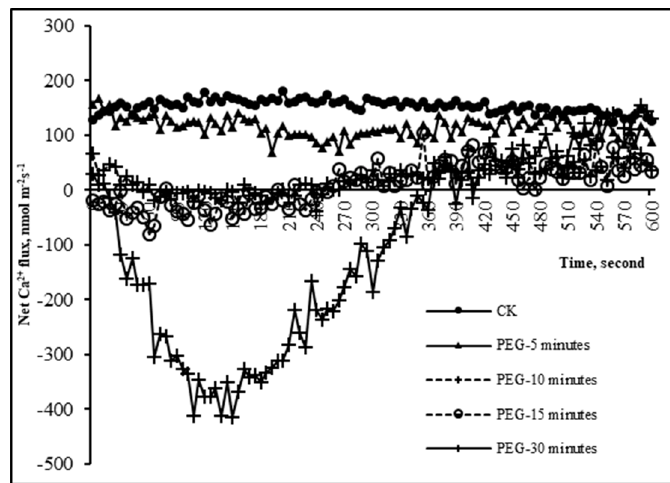
Figure 5. Changes in net Ca 2+ flux in the pileorhiza of P. edulis seedlings after PEG-induced drought stress. Real-time Ca 2+ flux by the pileorhiza of by PEG-induced drought stress for 5 min, 10 min, 15 min, 30 min, and CK, respectively (Data Repetition: 3 replicates).